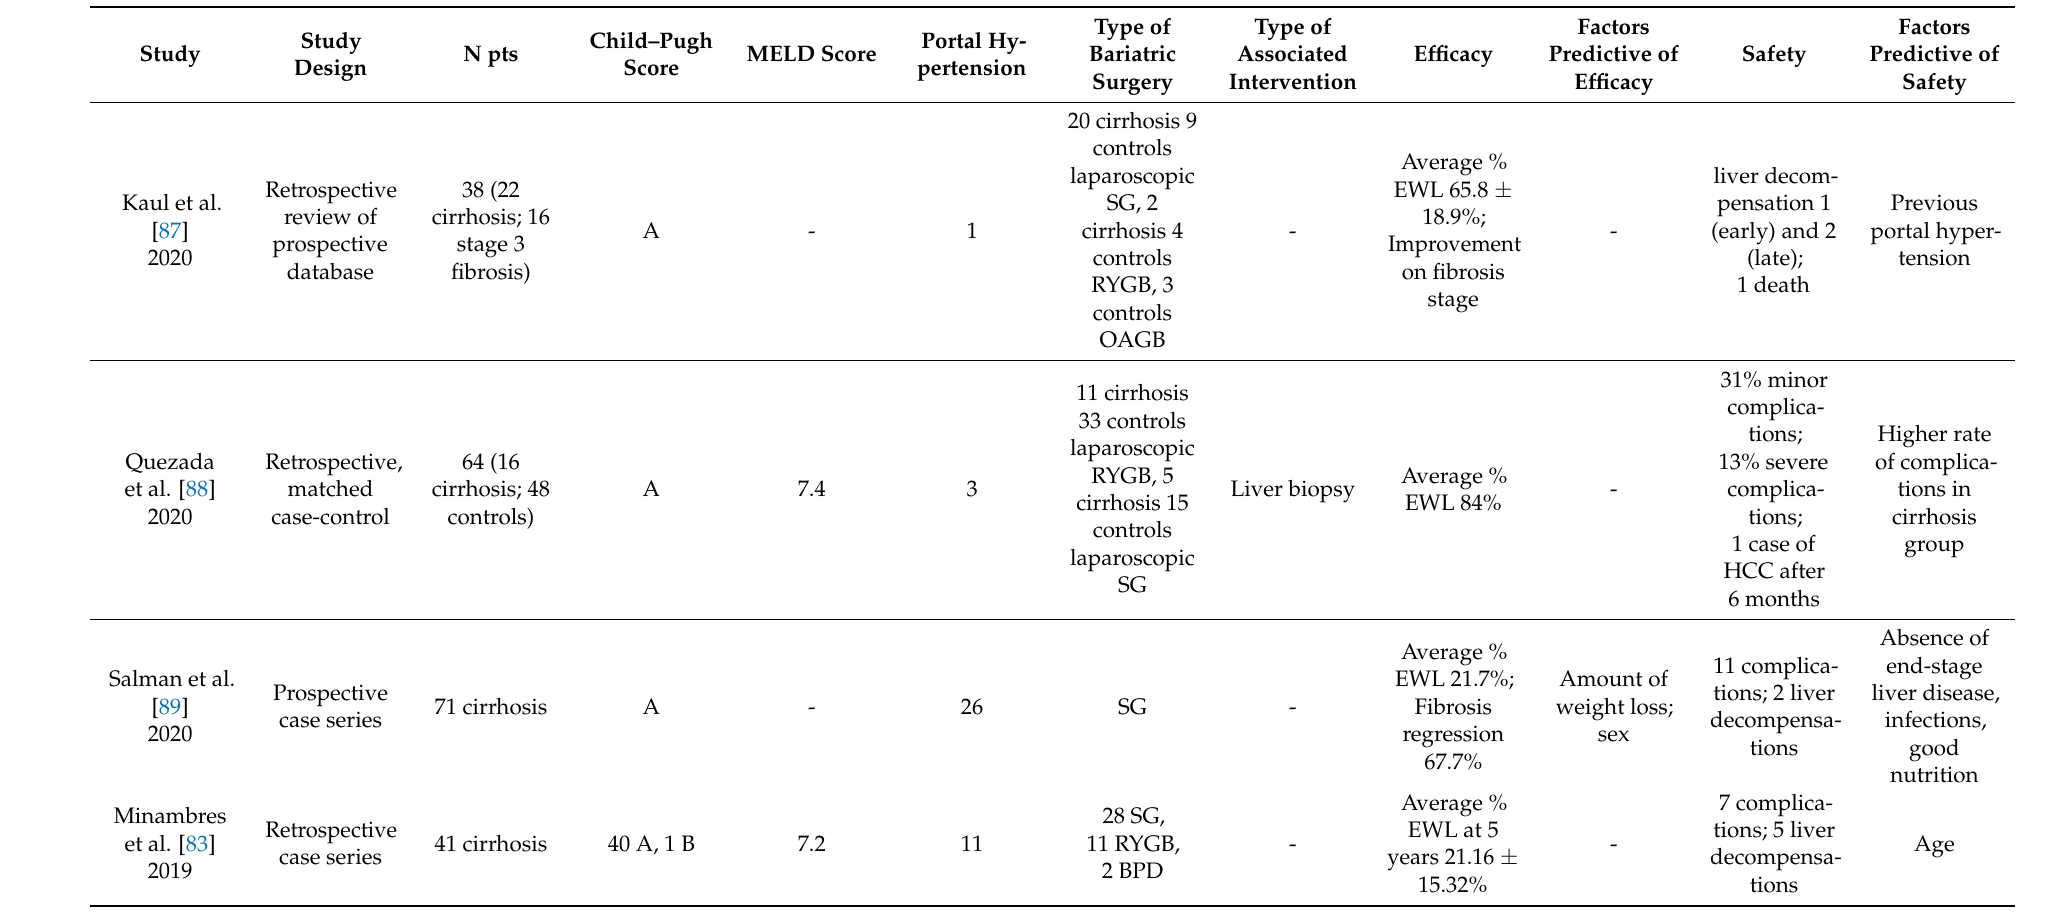
Table 1. Studies including cirrhotic patients with portal hypertension undergoing bariatric